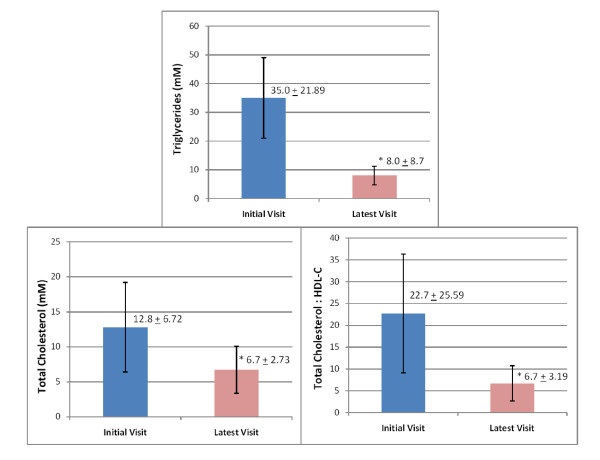
Triglycerides, Total Cholesterol, and Total Cholesterol:HDL-C Ratio at Initial and Latest Clinic Visit in HTG Patients. *, significant difference between means, p < 0.001 (two tail; pair student t-test).